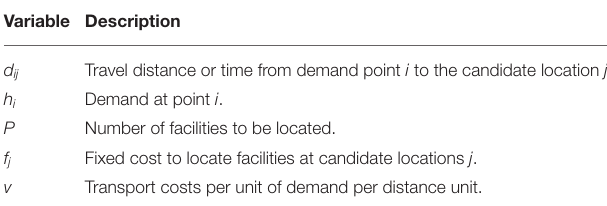
TABLE 1 | List of mathematical notations and input parameters.